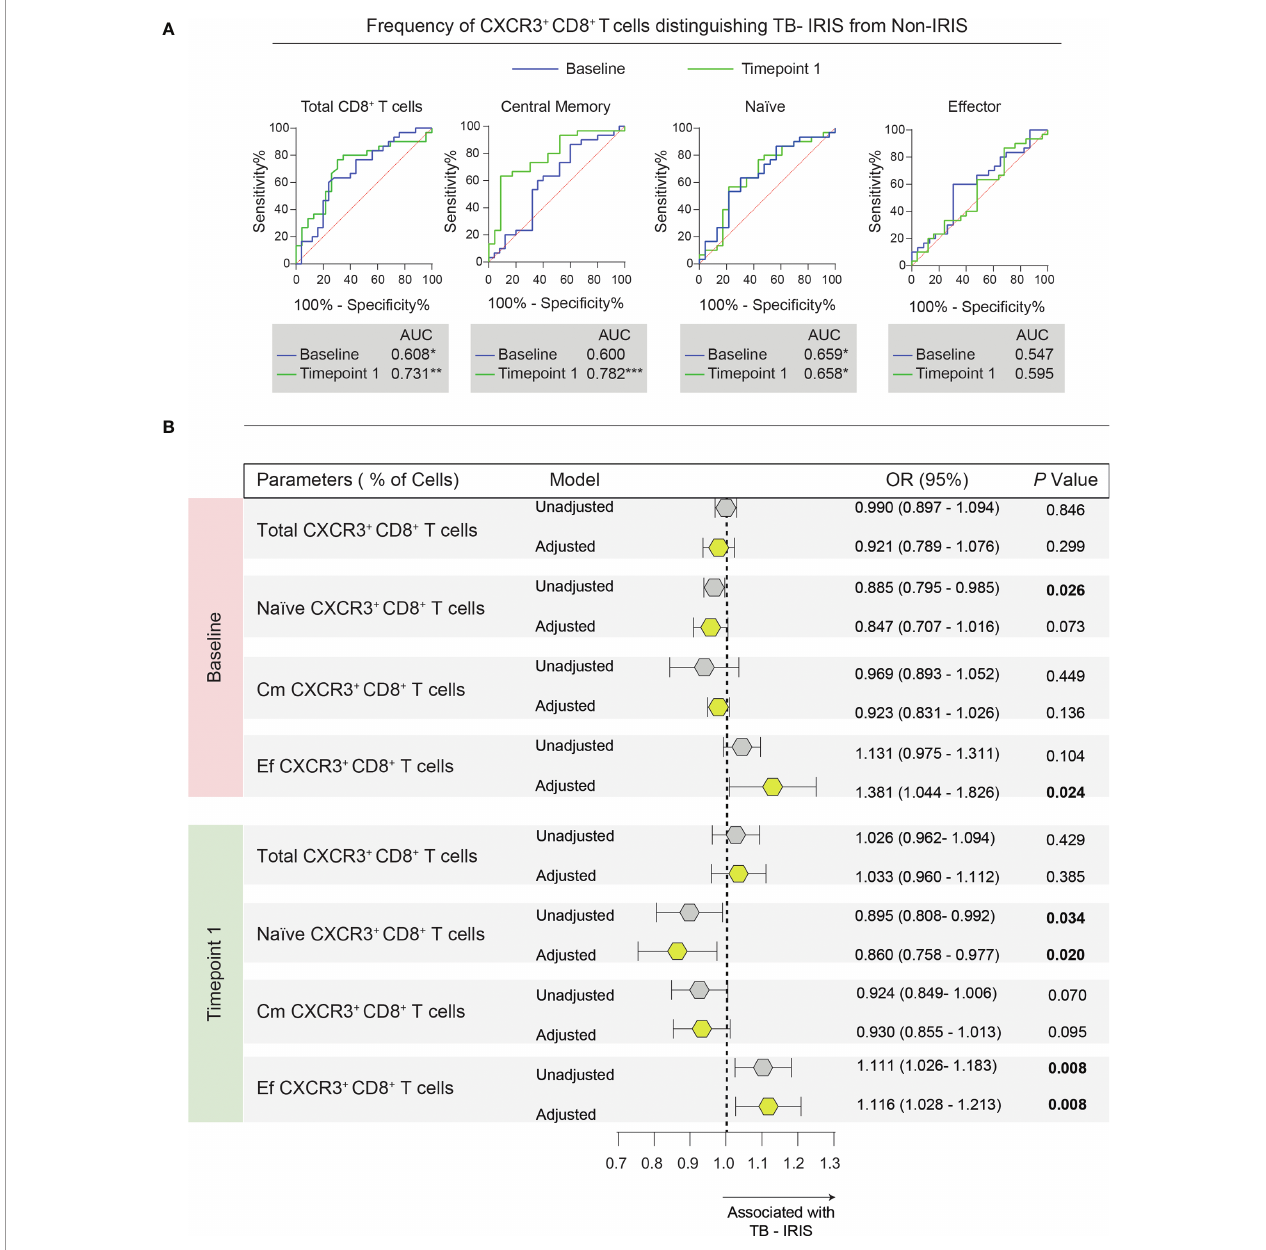
FIGURE 6 | Association between memory CD8 + T cell subsets expressing CXCR3 and the risk of TB-IRIS development. (A) Receiver operator characteristic (ROC) curves were employed to discriminate TB-IRIS from Non-IRIS patients at both timepoints taking into account the frequency of each fl ow cytometric population. (B) Multivariate regression analysis to evaluate the association between the frequencies of CXCR3 + memory CD8 + T cells and Mycobacterium tuberculosis immune reconstitution in fl ammatory syndrome (TB-IRIS). The multivariate model included the following variables: CD4 + T cell counts, viral load, smear grade, and the number of days between ATT and ART initiation. Odds ratios (OR) represent the 95% con fi dence interval increase in the frequency of each lymphocyte population. P values are shown in bold. Gray polygons represent unadjusted models, while yellow ones represent adjusted